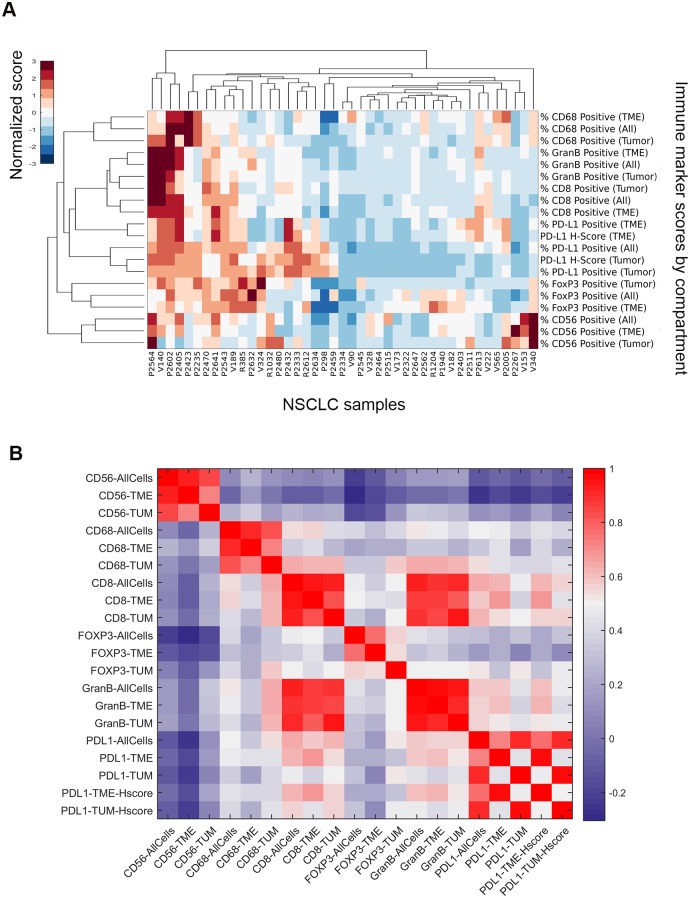
Relationships between biomarkers in our NSCLC cohort.(A) Hierarchical clustering heat map of percentages of positive cells for FOXP3, PD-L1, CD8, Granzyme B, and CD68. Each biomarker (row) was normalized before clustering to give a mean of 0 and a standard deviation of 1 across columns (samples). The color scale indicates the relative size of the biomarker score compared to the other samples in the cohort with blue = low, white = neutral, and brown = high. Bracket height indicates the degree of correlation between measurements with shorter brackets representing higher correlations and taller brackets representing smaller correlations. (B) Heatmap of Pearson correlation coefficients between percent positive cells measurements across samples for FOXP3, PD-L1, CD8, Granzyme B, and CD68. The color scale ranges from the minimum (blue) and maximum (red) correlation coefficient observed in this analysis. Therefore red represents strong positive correlations, white represents moderate correlations, and blue represents weak correlations. No strong negative correlations were observed.